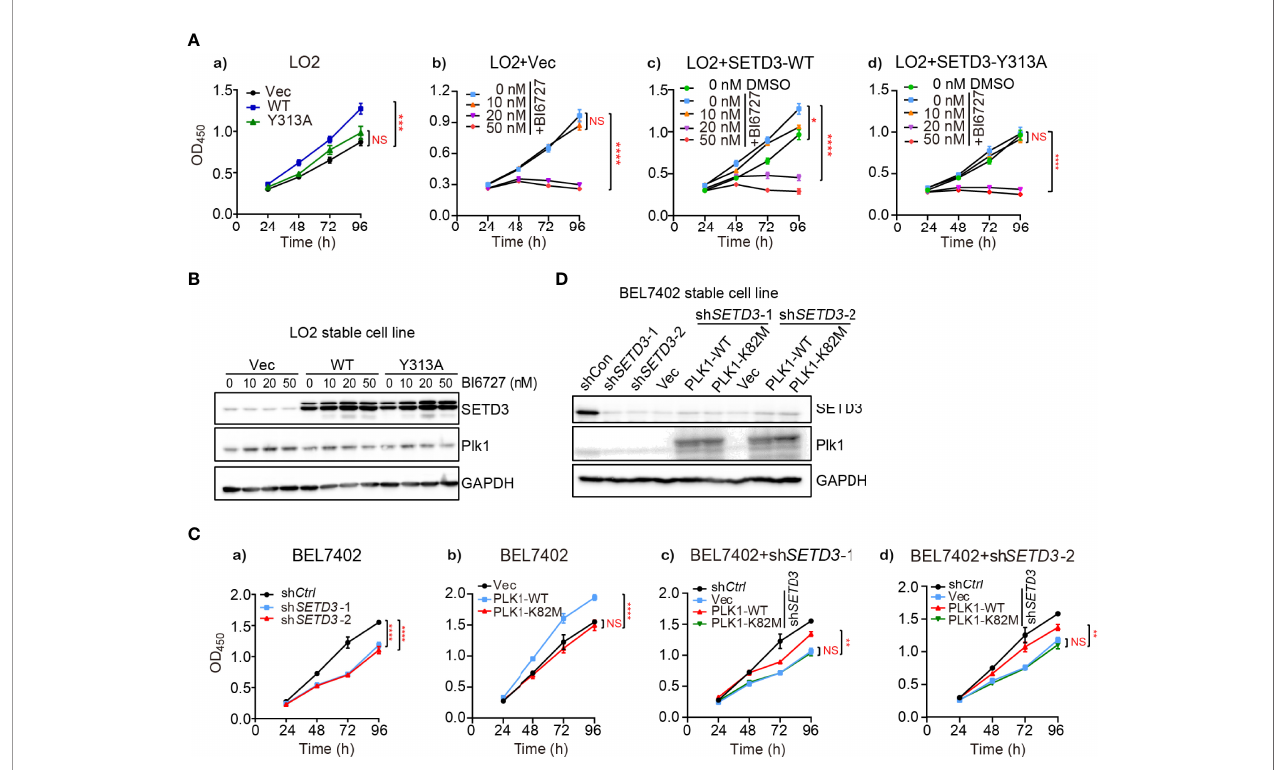
FIGURE 2 | Inhibition of PLK1 activity attenuates the effect of SETD3-enhanced cell proliferation. (A) Cell proliferation was determined by CCK-8 assay in LO2 cells transfected with the indicated SETD3 constructs. Cells were treated with different doses of the PLK1 inhibitor of BI6727 ( A, b – d ). (B) Protein levels of SETD3 and PLK1 were examined by Western blotting. (C) Cell proliferation was determined by CCK-8 assay in either WT (a, b) or sh SETD3 (c, d) BEL7402 cells overexpressing the indicated plasmids including WT or K82M mutant of PLK1. (D) Protein levels of SETD3 and PLK1 were examined by Western blotting. Data are presented as mean ± SEM. NS, not signi fi cant; * p < 0.05; ** p < 0.01; *** p < 0.01; **** p <